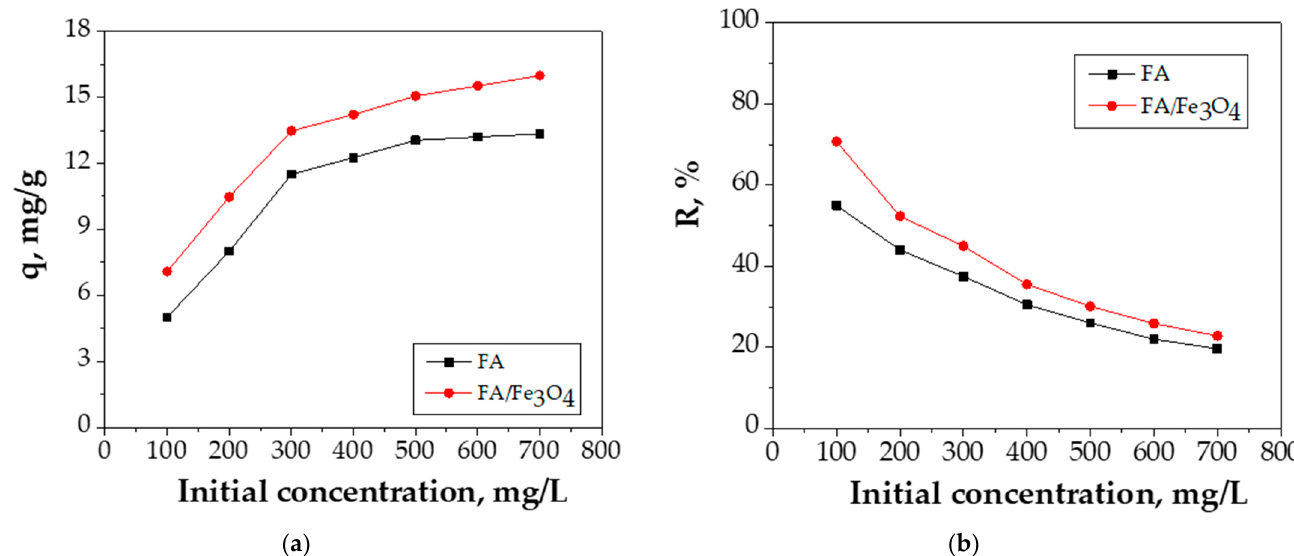
Figure 8. The effect of initial concentration on: ( a ) adsorption capacity, ( b ) adsorption efficiency (experimental conditions—initial pH = 5.0; adsorbent dosage = 0.2 g adsorbent/20 mL Cu (II) solution; contact time = 24 h; temperature = 26 °C) .